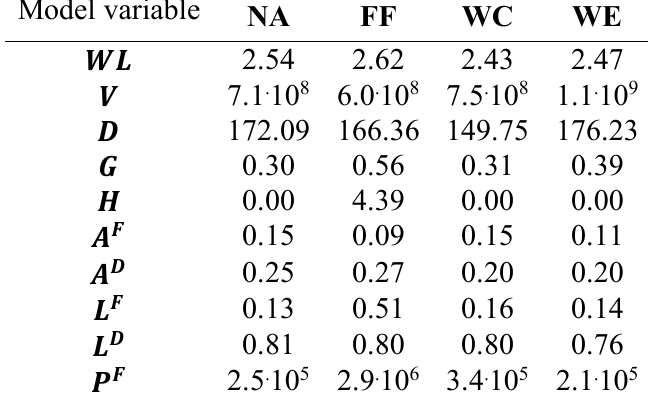
Table A4. Average values of different model variables obtained for the synthetic experiment additional scenario #3 with dam construction and four water management strategies (NA: No Actions; FF: Fighting Floods; WC: Water Conservation; WE: Water Exploitation)